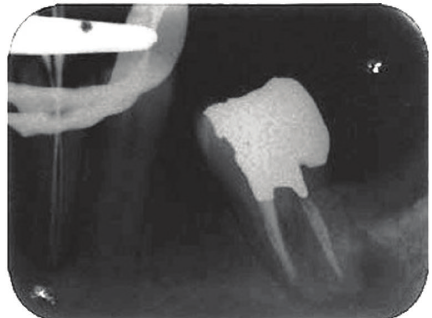
Figure 2: Working length radiograph confirming three root canal orifices.